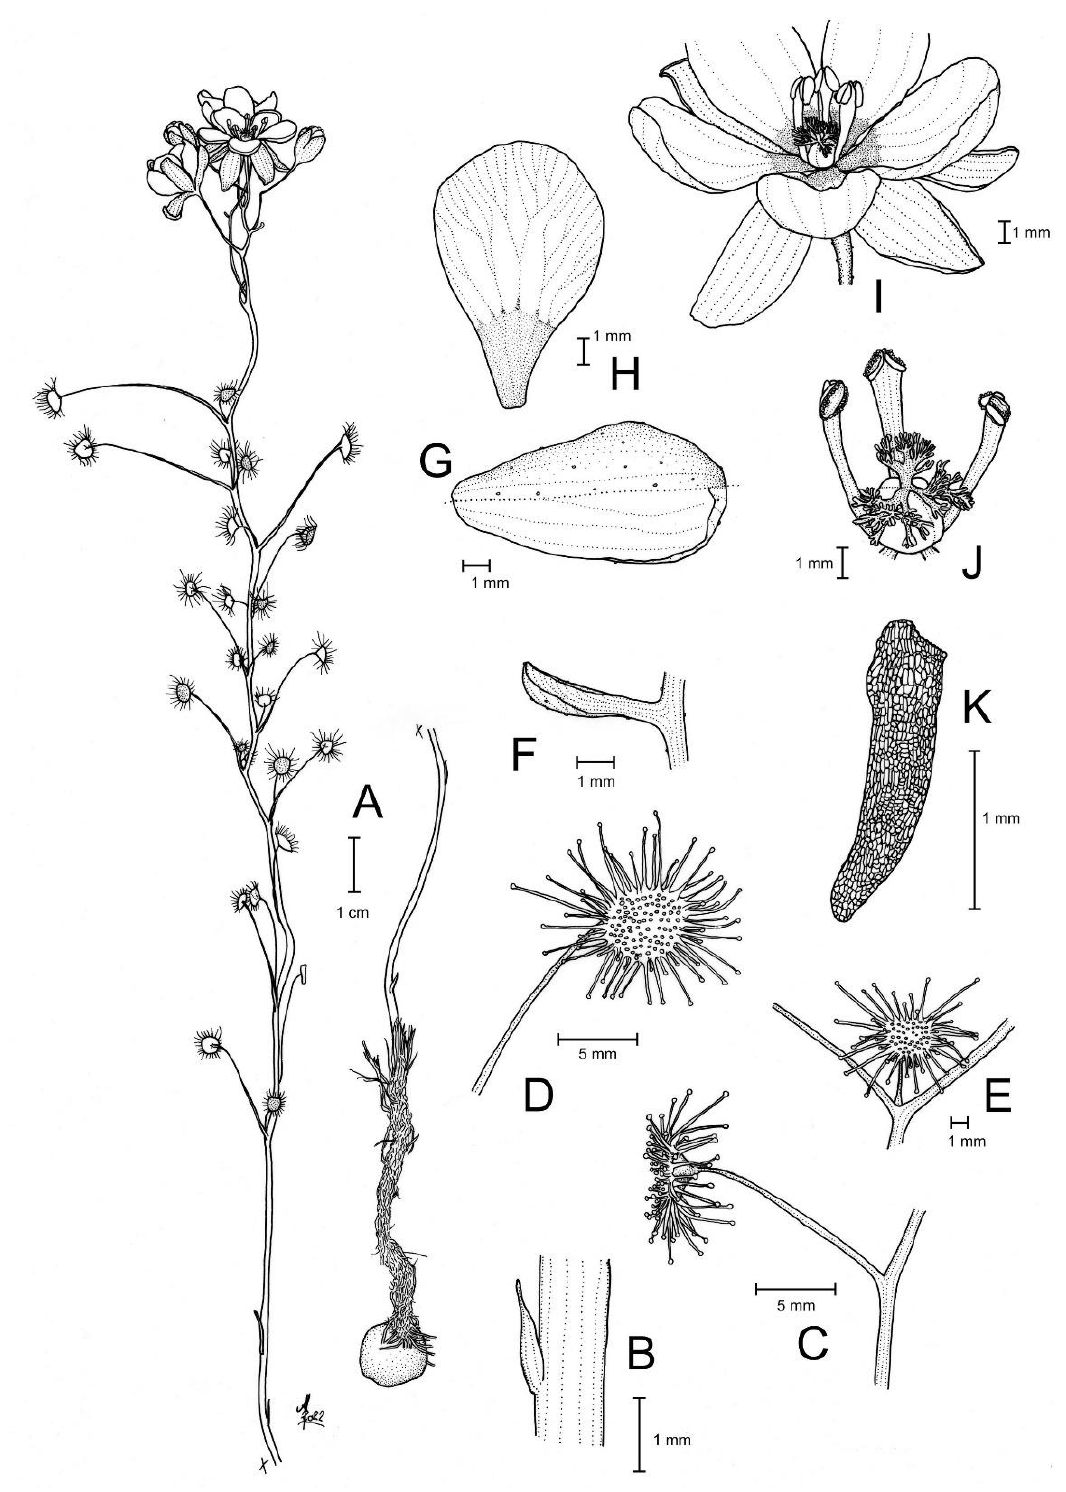
Figure 12. Drosera macropetala (Diels) T.Krueger & A.Fleischm. ( A ) habit; ( B ) cataphyll from stem base; ( C ) cauline leaf from lower part of the stem; ( D ) lamina, adaxial view; ( E ) axillary leaf from a stem upper node; ( F ) bract; ( G ) sepal, top half abaxial view, lower half adaxial view; ( H ) petal; ( I ) flower (two stamens removed to reveal the ovary); ( J ) gynoecium, with two stamens removed; and ( K ) seed. ( A ) from the type ( J. Drummond coll. VI n. 109 ); ( B , D , G , H ) from T. Krueger 29 ; ( C , E , F , H – K ) from photographs of living plants from near Dandaragan, Western Australia. Drawing: A. Fleischmann.